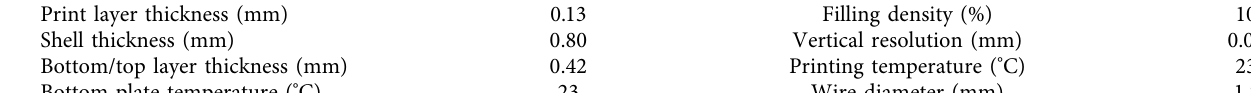
Table 2: Graphene nanosilver printing parameters.